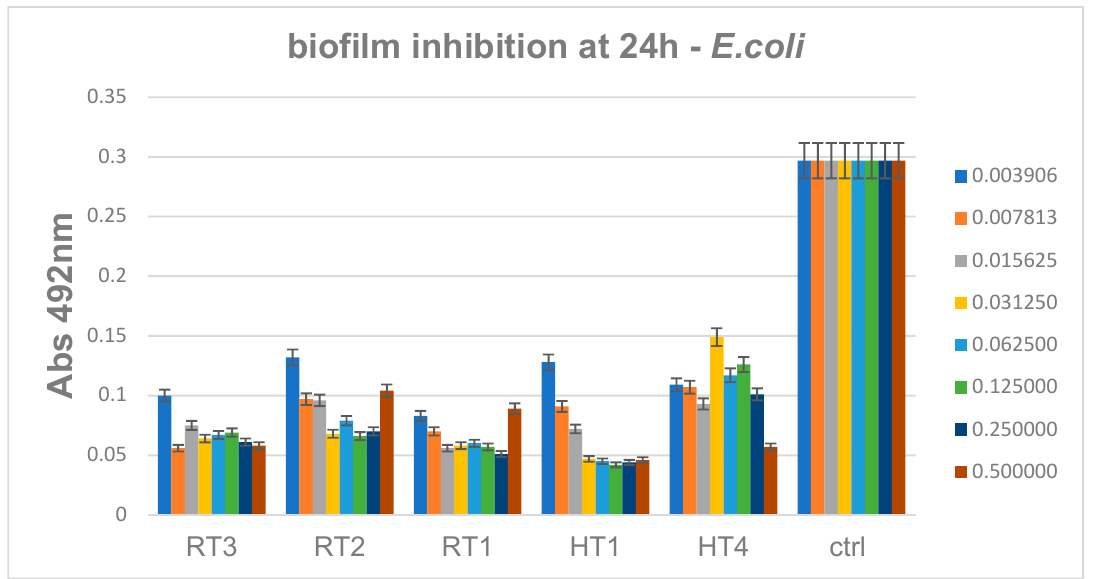
Figure 17. Inhibition of E. coli biofilm development in the presence of the obtained AgNPs for 24 h, p < 0.001 when comparing Abs 492 nm values of RT and HT samples to control .